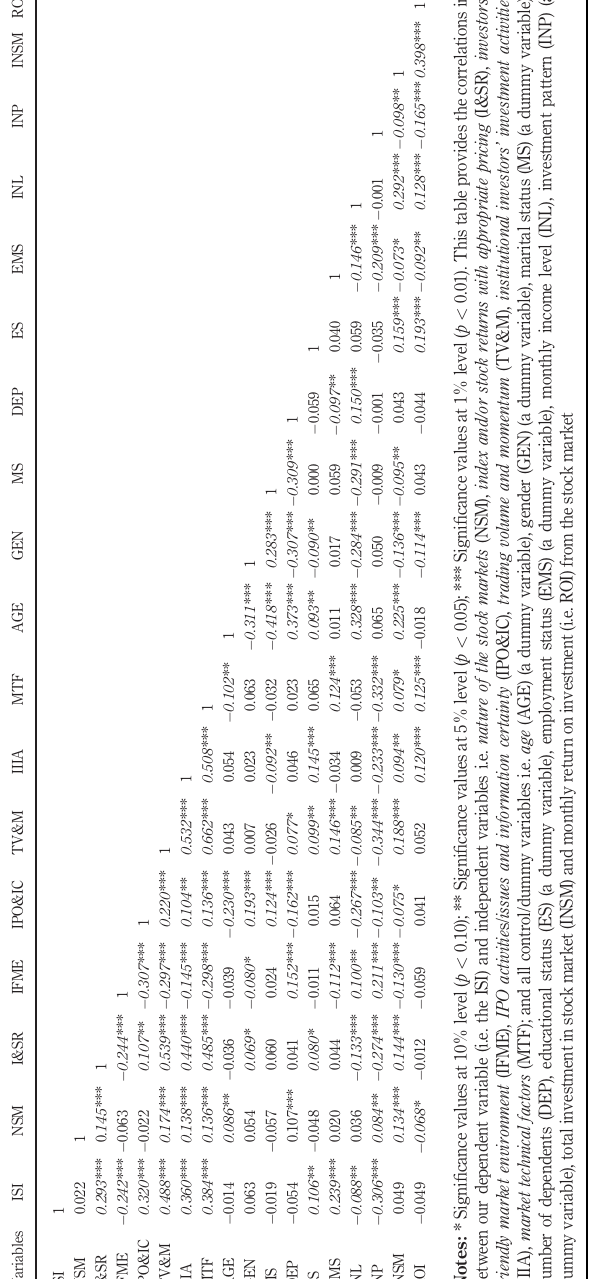
Table 2. Correlations